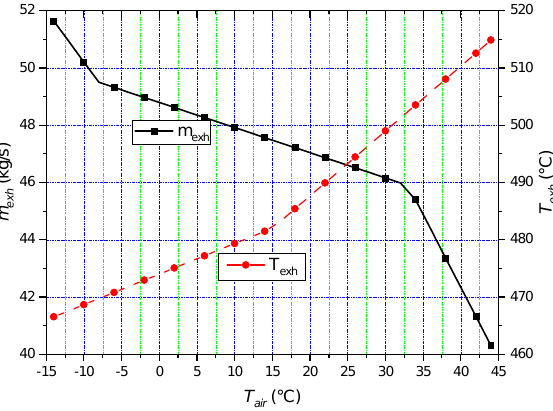
Figure 3. Mass flow rate and temperature exhaust from GE10 gas turbine, varying ambient